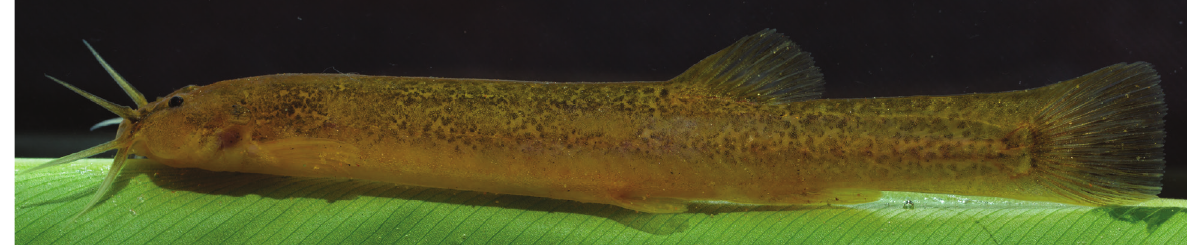
Figure 3. Cambeva davisi , topotype, UFRJ 9759, 67.6 mm SL; Brazil: Paraná: Balsa Nova. Photograph by A. M. Katz.